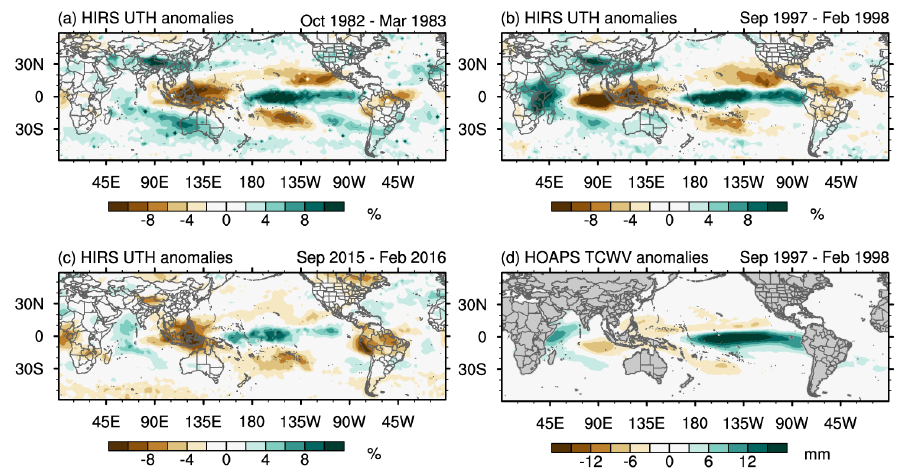
Figure 5. Anomalies during the peak six months of several very strong El Niño events for ( a – c ) UTH